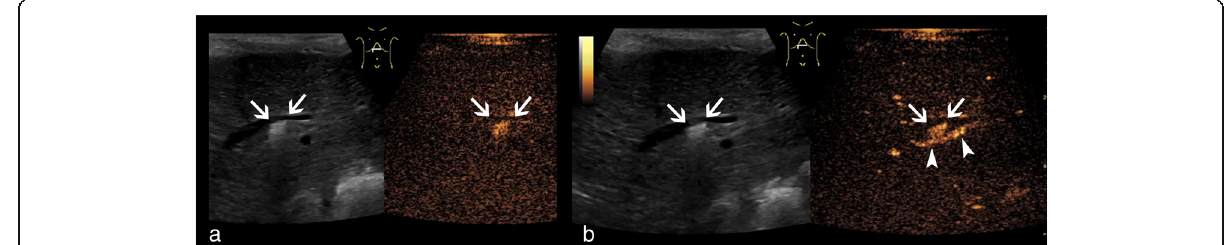
Fig. 2 Post-interventional sonography displayed in contrast mode with split-screen; B-mode images are visible on the left, and contrast-mode images on the right side respectively. a Post-interventional ultrasound before contrast medium injection detects artifacts of coils (arrows) on B- mode (left side) contrast-mode images (right side). b Post-interventional contrast-enhanced sonography during arterial phase shows coils artifacts without contrast-enhancement of the pseudoaneurysm (arrow) and patency of the SIII artery (arrow heads) on B-mode (left side) and contrast- mode imaging (right